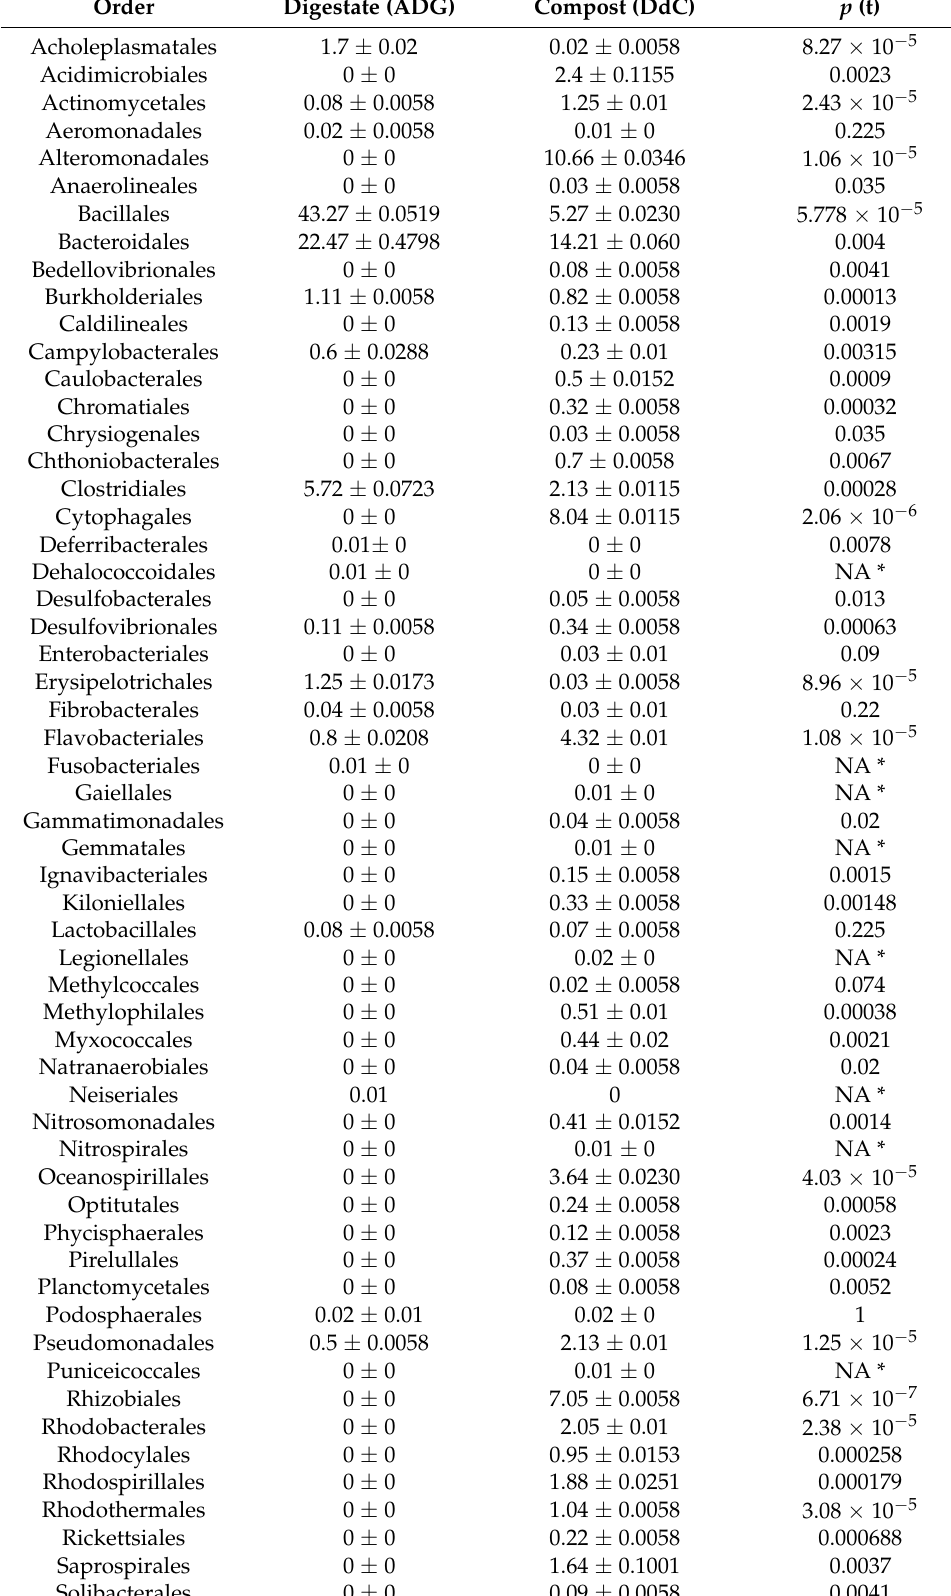
Table 2. Relative abundance (mean ± standard errors) of all microbiota at orders level in digestate and digestate derived-compost and p values of Student’s t